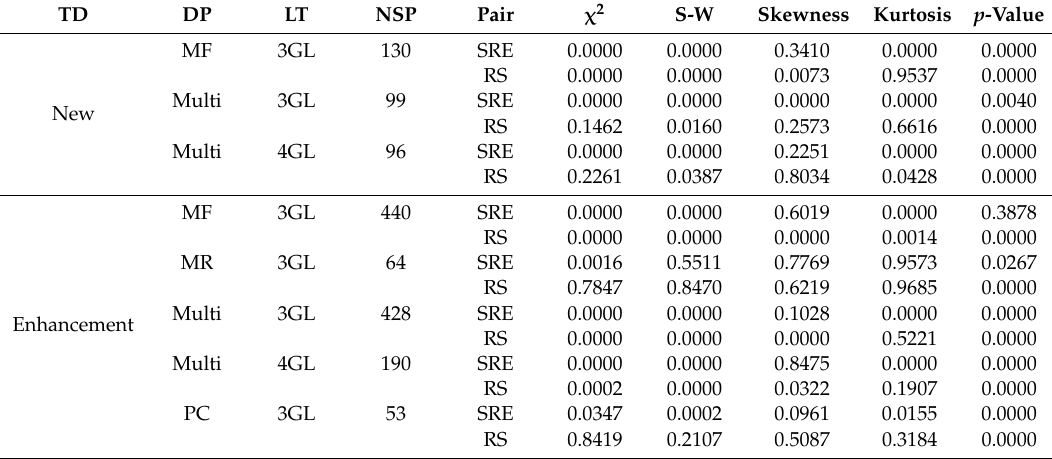
Table 10. Statistical tests for data distribution and between models by data set. PSO: ( PSO-SRE – SRE), RS: ( PSO-SRE –